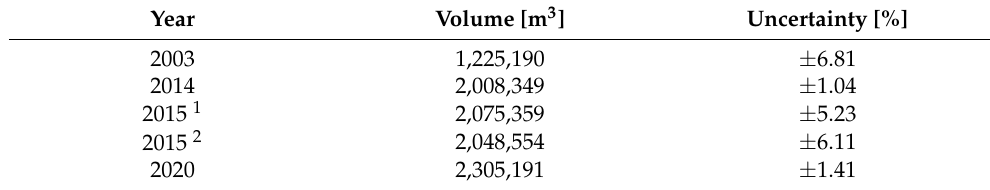
Table 3. Estimated increase in the volume of the dump canopy of landfill in Promnik in 2003–